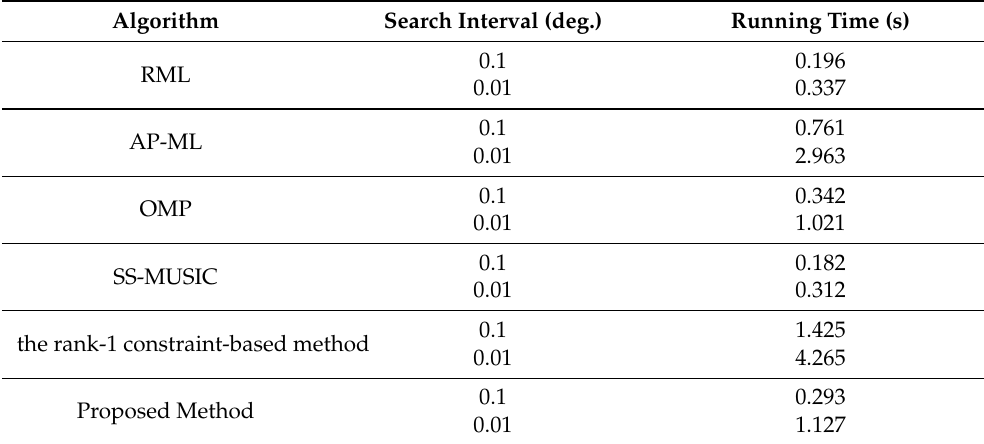
Figure 6. Estimation results of target location parameter across the observation time. ( a ) Target direction estimates achieved by different algorithms. ( b ) Target height estimates achieved by differ- ent algorithms. Table 4. Average running times of different